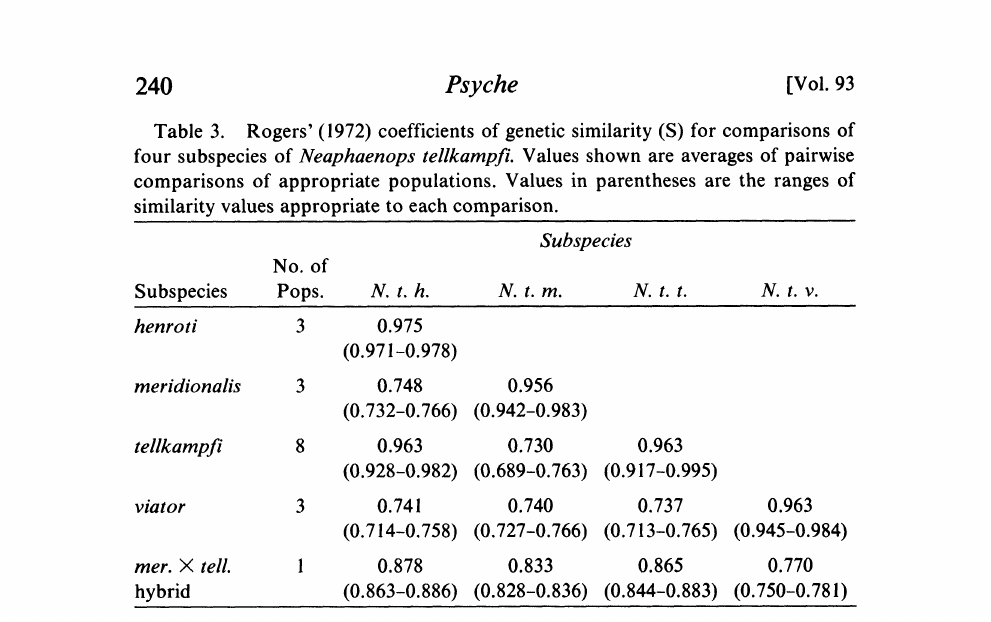
Table 3. Rogers’ (1972) coefficients of genetic similarity (S) for comparisons of four subspecies of Neaphaenops tellkampfi. Values shown are averages of pairwise comparisons of appropriate populations. Values in parentheses are the ranges of similarity values appropriate to each